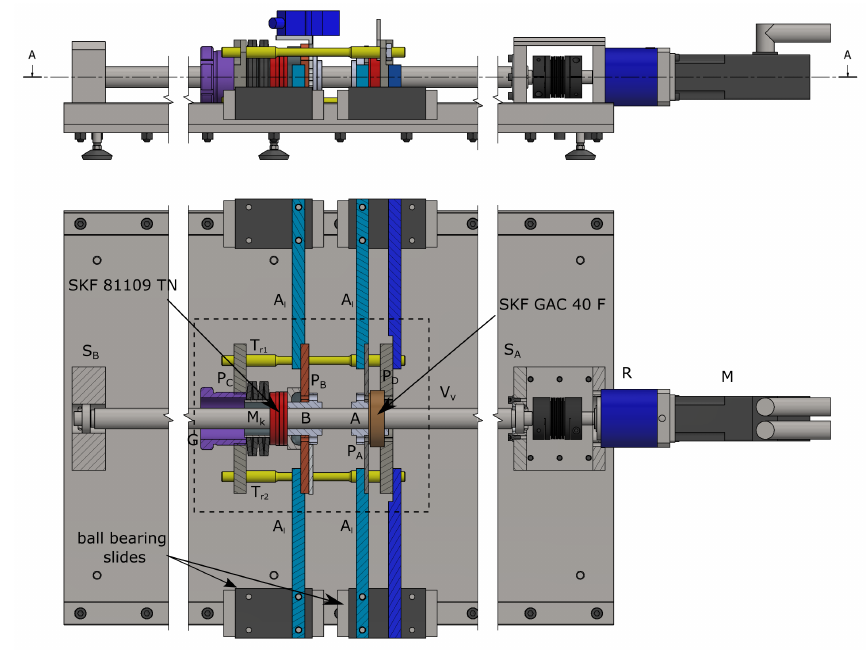
Figure 2. Test rig top and side